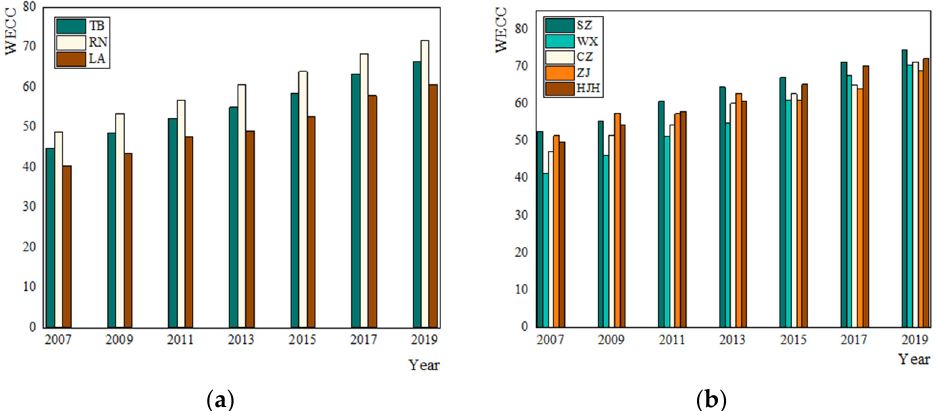
Figure 4. WECC dynamic development trend from 2007 to 2019. ( a ) Taihu Basin, river network area and Taihu lake area. ( b ) Administrative regions in the Taihu Basin.